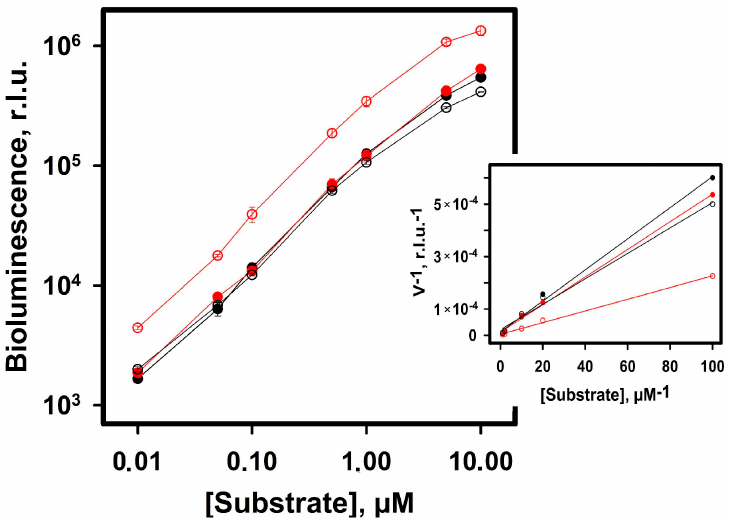
Figure 4. Log–log plots of NanoLuc luciferase bioluminescence assay and Lineweaver–Burk plot (inset) with furimazine (red empty circles), FMZ-apoCBP (red filled circles), coelenterazine (black empty circles), and CBP (black filled circles). The luciferase concentration is 1 nM in all experiments. The points on the plots are average of three measurements. r.l.u.—initial bioluminescence intensity in relative light